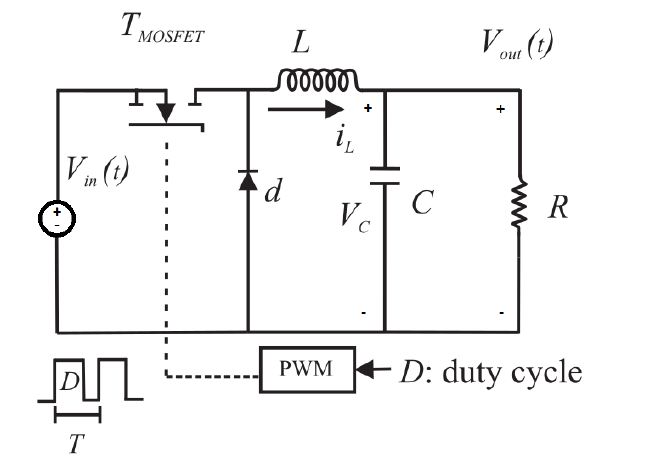
Figure 1. Topology of a buck converter system.